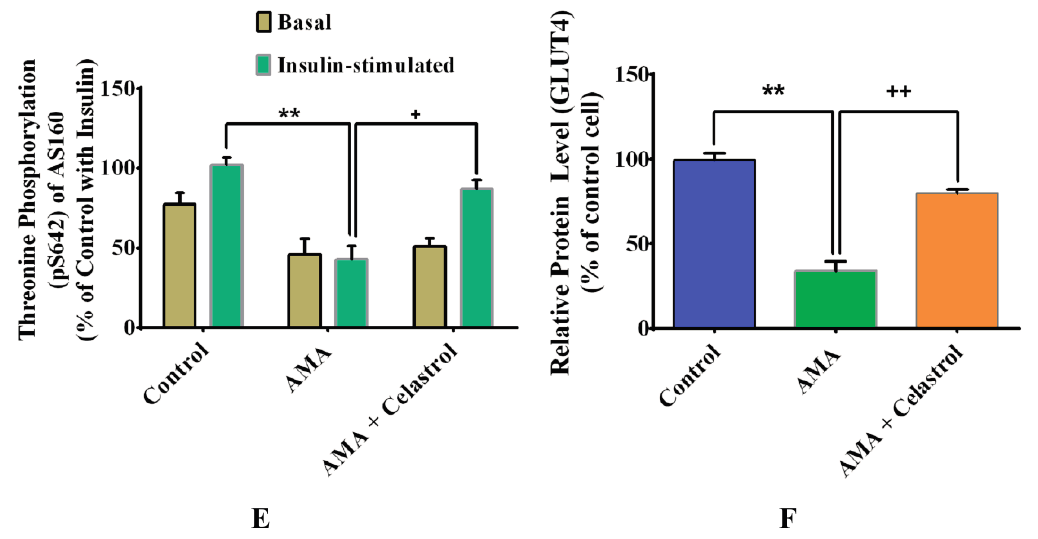
E F Figure 8. Effects of AMA and celastrol treatment on insulin signaling pathways and glucose transporters (GLUT4) of human myotubes. Cells were treated with AMA (30 µM) for 48 h before incubation with celastrol (15 nM). β -actin was used as an internal protein loading control. Protein levels for each corresponding antibody obtained from densitometry were normalized to the β -actin signal ( A – F ). * p < 0.05 and ** p < 0.01 vs . untreated control; # p < 0.05 vs . basal rate; + p < 0.05 and ++ p < 0.01 vs . AMA-treated